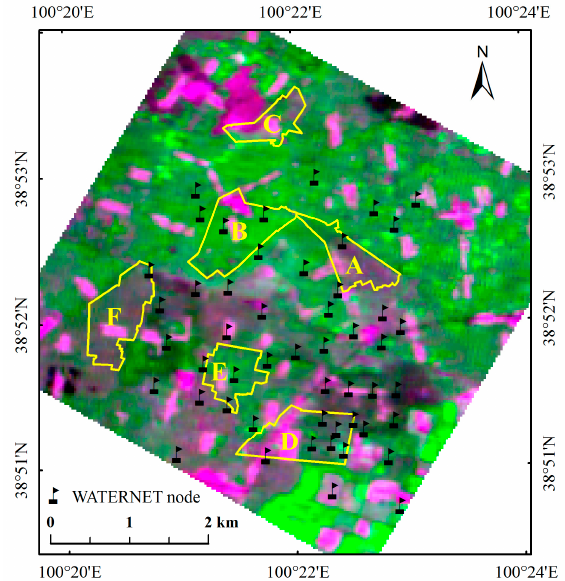
Figure 1. Study area in the middle reaches of the Heihe River Basin: the image was obtained from HJ satellite, combined by band 3 (RED), band 4 (NIR) and band2 (GREEN); the numbered yellow polygons indicate the selected irrigation fields in study area: A is JC-6, B is SQ-1, C is STZ-1, D is WX-4, E is XM-2, and F is ZH-6.